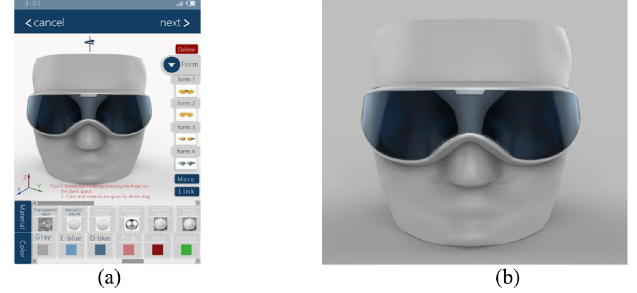
Fig. 22. Appearance of the designed swimming goggles.